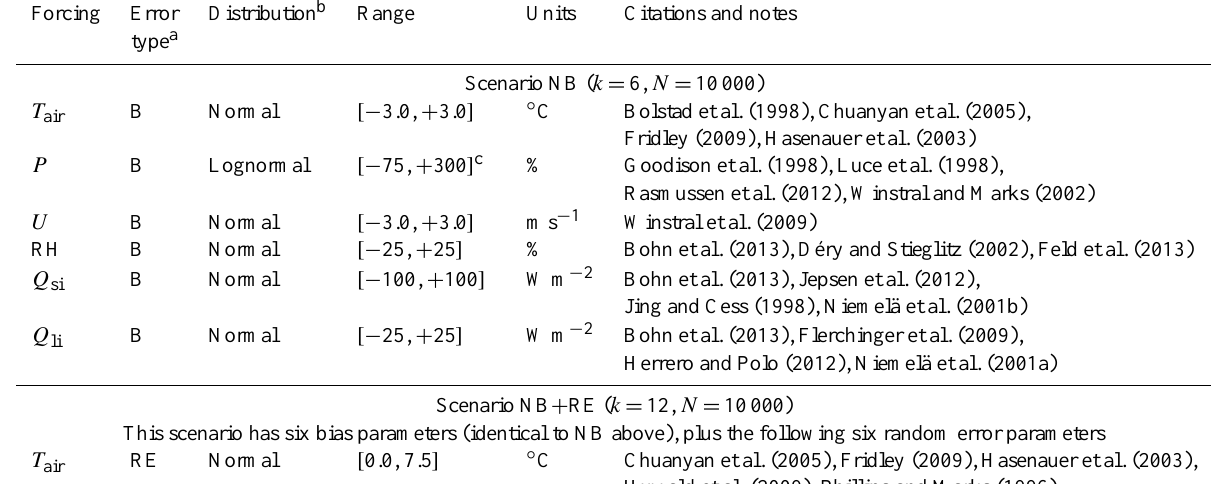
Table 3. Details of error types, distributions, and uncertainty ranges for the five scenarios.